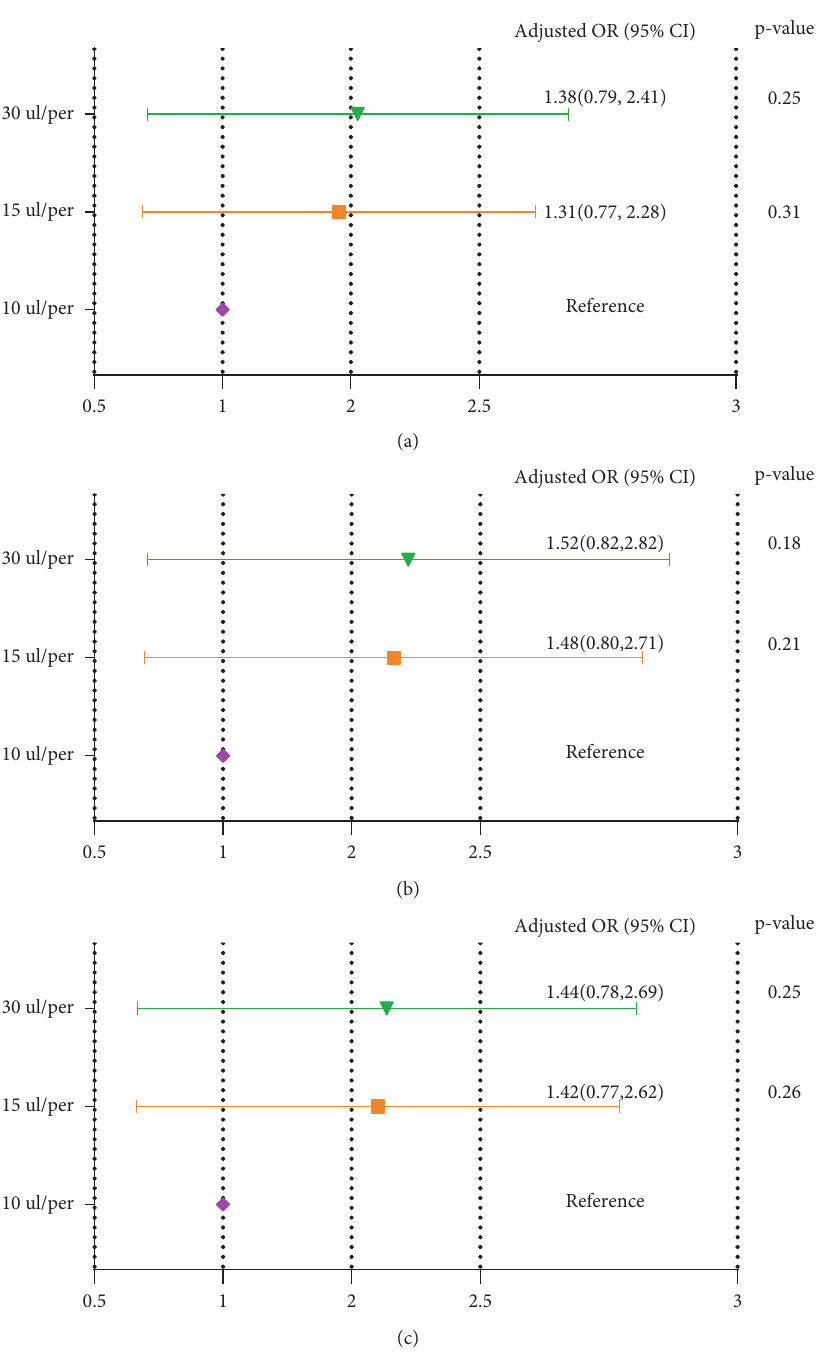
Figure 5: Relationship between embryo density and clinical results in different models. The analysis was performed by GEE (generalized estimate equation) model, subject ID � patient unique medical record number (independence). (a) Crude model: no factor was adjusted; (b) Model I: maternal age, paternal age, AMH, and length of stimulation were adjusted; (c) Model II: maternal age, paternal age, maternal BMI, type of infertility, type of insemination, COS protocol, AMH, the number of retrieved oocytes, length of stimulation, antral follicles, incubator, and culture medium were